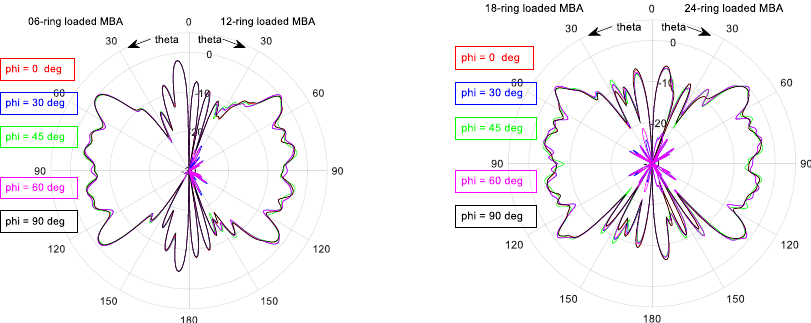
Figure A6. 2D patterns at 27 GHz of 6-, 12-, 18- and 24-ring-loaded MBA in different cutting planes.